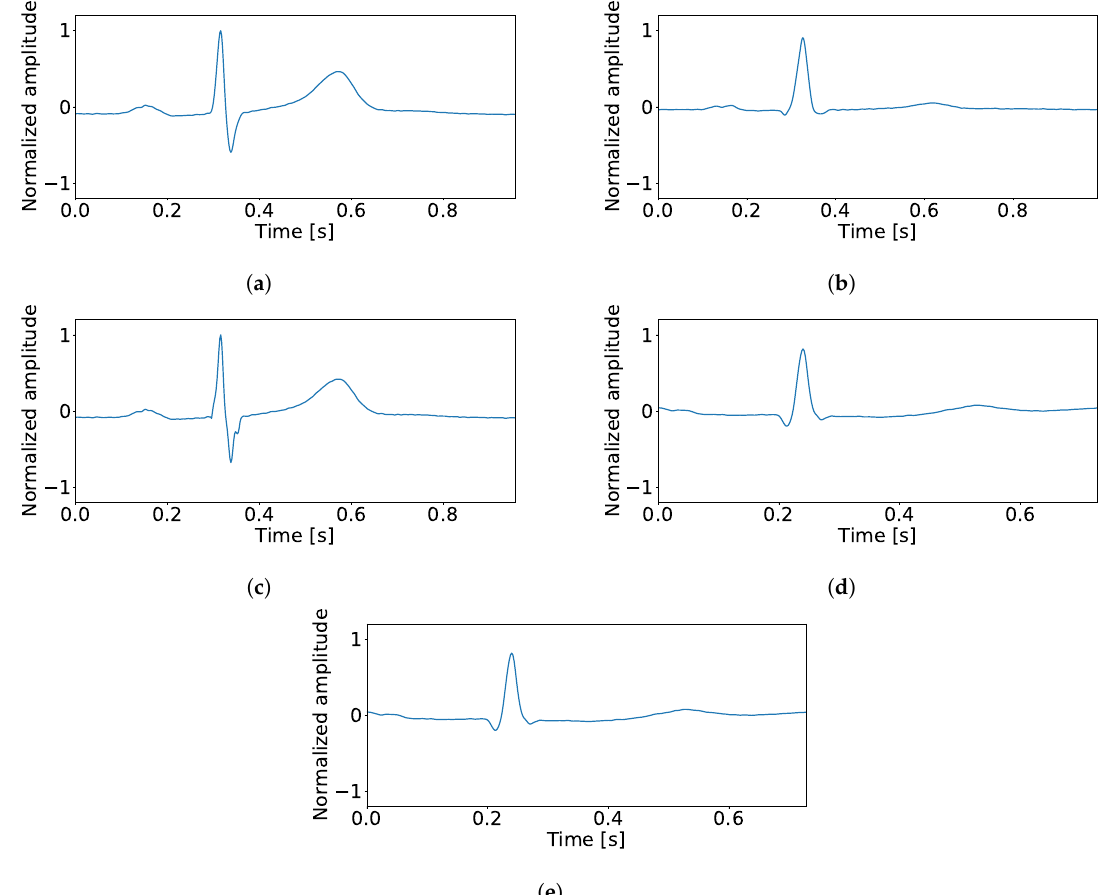
Figure 1. Example for each kind of record used in this work, namely: ( a ) Control record from subrogated fragmented database (Sfrag-DB); ( b ) Subrogated fragmented record from Sfrag-DB; ( c ) Subrogated wide-fragmented (SWfrag-DB) record; ( d ) Fragmented record from FHCM-DB; And ( e ) record affected by fibrosis from